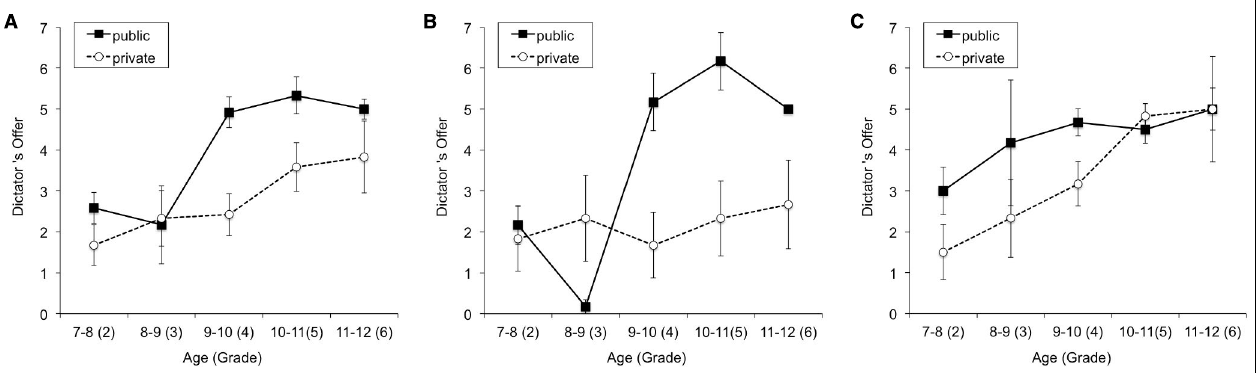
FIGURE 3 | Mean level of dictator’s offer in each condition. All children (A), boys (B), and girls (C). Error bars indicate standard error of the